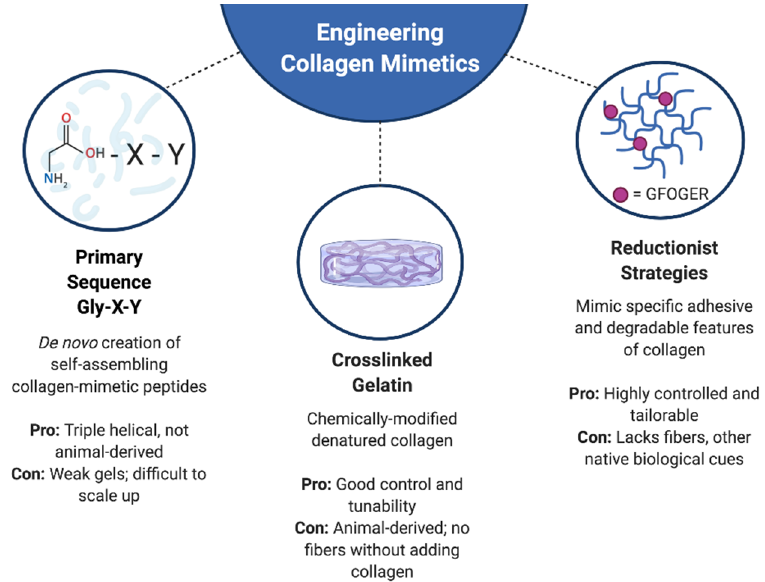
Figure 2. Overview of common approaches used to engineer collagen-mimetic matrices. Figure created using BioRender.com.